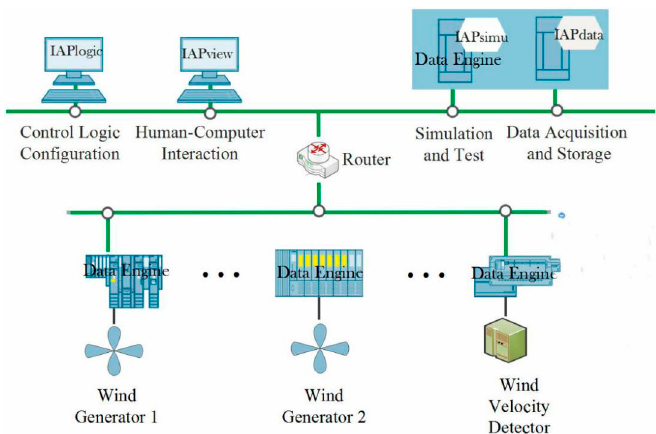
Figure 2. The software framework of a parallel wind energy conversion system (PWECS).